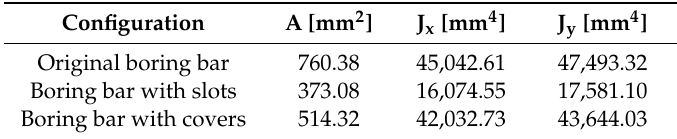
Table 6. Comparison between original boring bar, boring bar with slots and active boring bar with